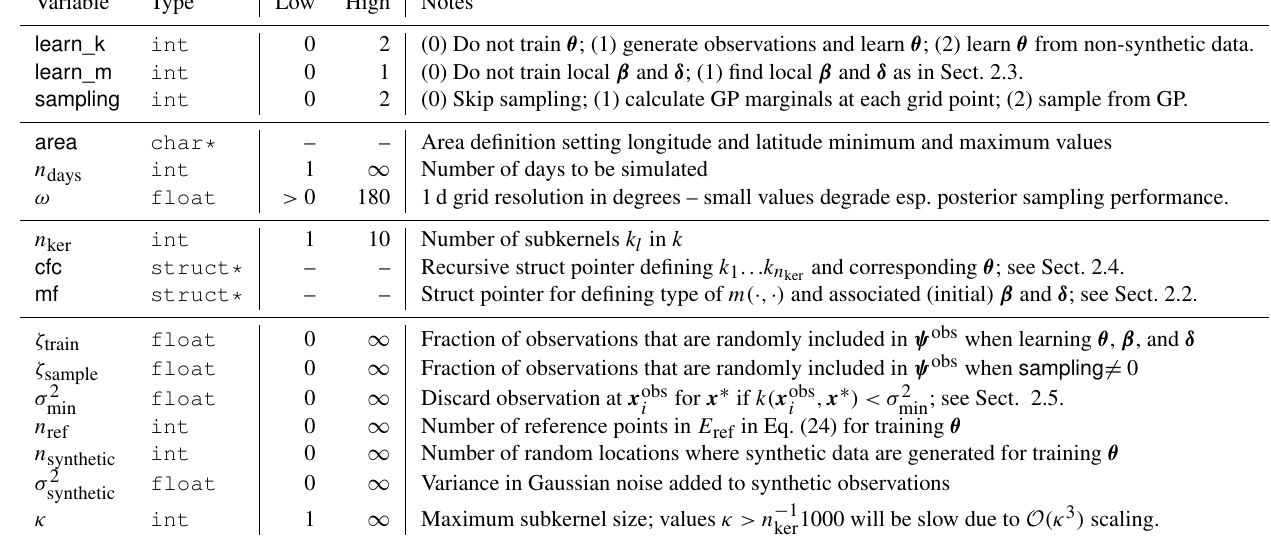
Table 2. Most important satGP control variables and high-level C structs: first section contains parameters for program logic, second for domain specification, third for covariance and mean function definition, and last for observation handling. This list is by no means exhaustive – the configuration file contains lots of variables that can control the program. Some additional tweaking is possible by changing hard-coded values directly in the source code, such as those listed in Appendix